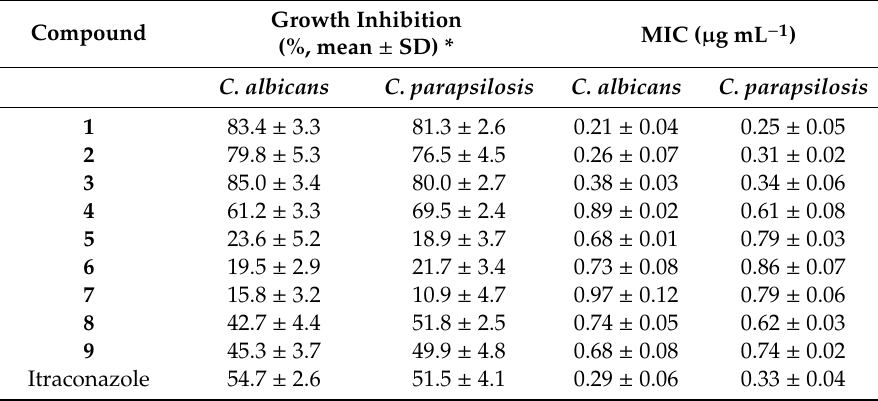
Table 2. Antifungal activity of compounds 1 – 9